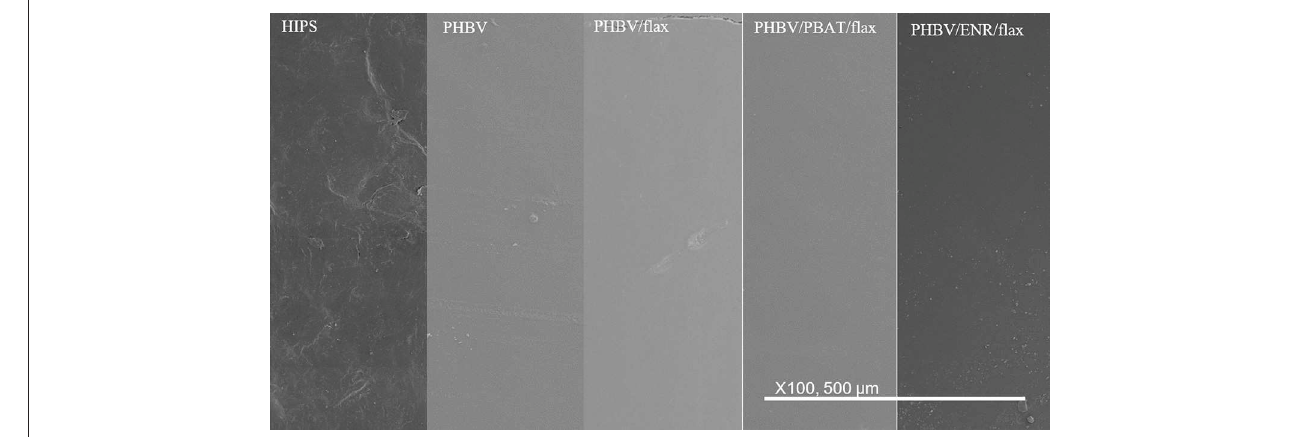
FIGURE 9 | SEM images of initial surfaces of all materials.